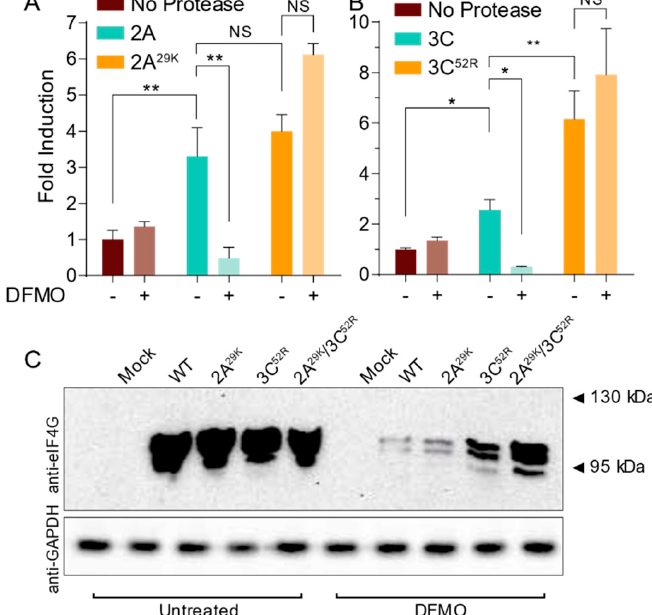
Figure 5. CVB3 protease mutations enhance proteolytic activity in polyamine-depleted cells. ( A ) 293T cells were treated with 500 µM DFMO or left untreated and transfected with empty vector, wildtype 2A, and mutant 2A. Protease activity was measured via dual luciferase assay at 24 h. ( B ) 293T cells were treated and transfected as in (A) but using wildtype and mutant 3C constructs. ( C ) Vero cells were left untreated or treated with 500 µM DFMO for four days prior to infection with wildtype and protease mutant CVB3. At 24 hpi, total cellular protein was collected and analyzed for eIF4G and GAPDH. * p ≤ 0.05, ** p ≤ 0.01, *** p ≤ 0.001, or not significant (NS) using Student’s t test ( n ≥ 3), comparing treated samples to untreated controls. Error bars represent ± 1 SEM.